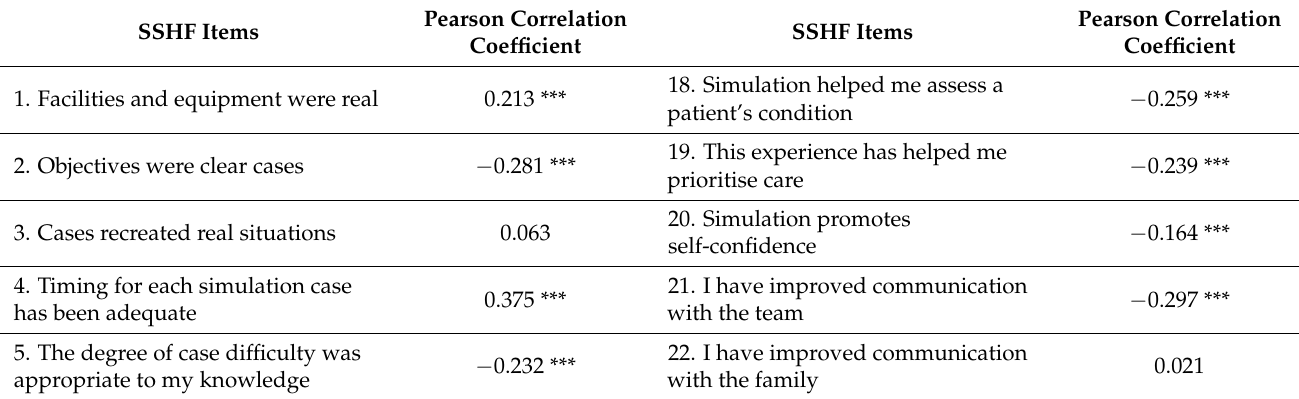
Table A2. Bivariate correlations of type of simulation and SSHF